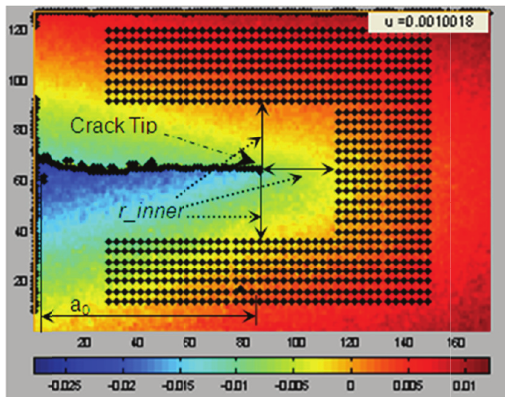
P model in th digital image T -stress as fo onents T x in